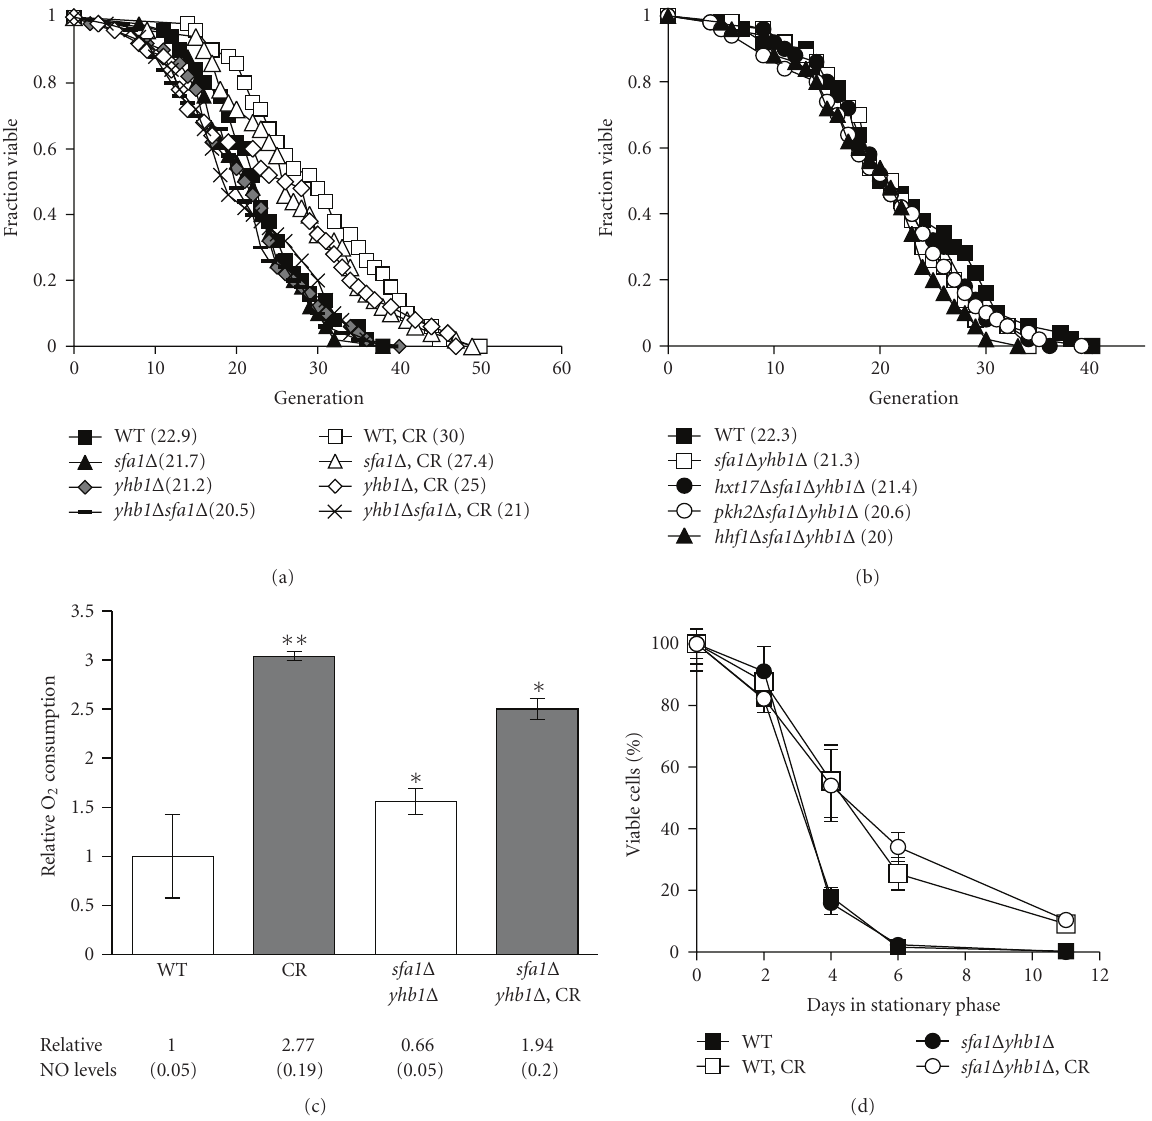
Figure 5: Balanced NO metabolism is required for CR-induced beneficial e ff ects. (a) CR fails to extend RLS in cells lacking Sfa1 and Yhb1. (b) CR genetic mimics fail to extend RLS in cells lacking Sfa1 and Yhb1. (c) Deleting Sfa1 and Yhb1 partially a ff ect CR-induced increase in oxygen consumption and NO levels. (d) Sfa1 and Yhb1 are not required for CR-induced CLS. One representative set of experiments is shown. Error bars denote standard deviations. P values are calculated using Student’s t -test ( ∗ P < . 05; ∗∗ P < . 01; ∗∗∗ P < .